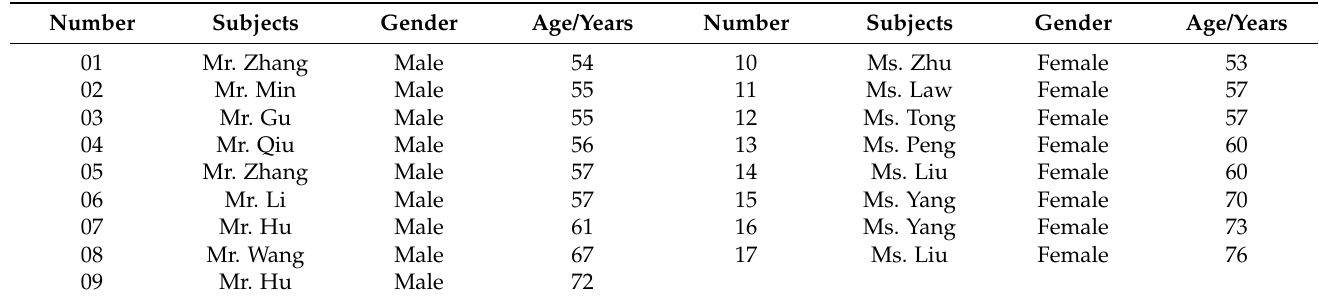
Table 1. Subject sex and age information table.